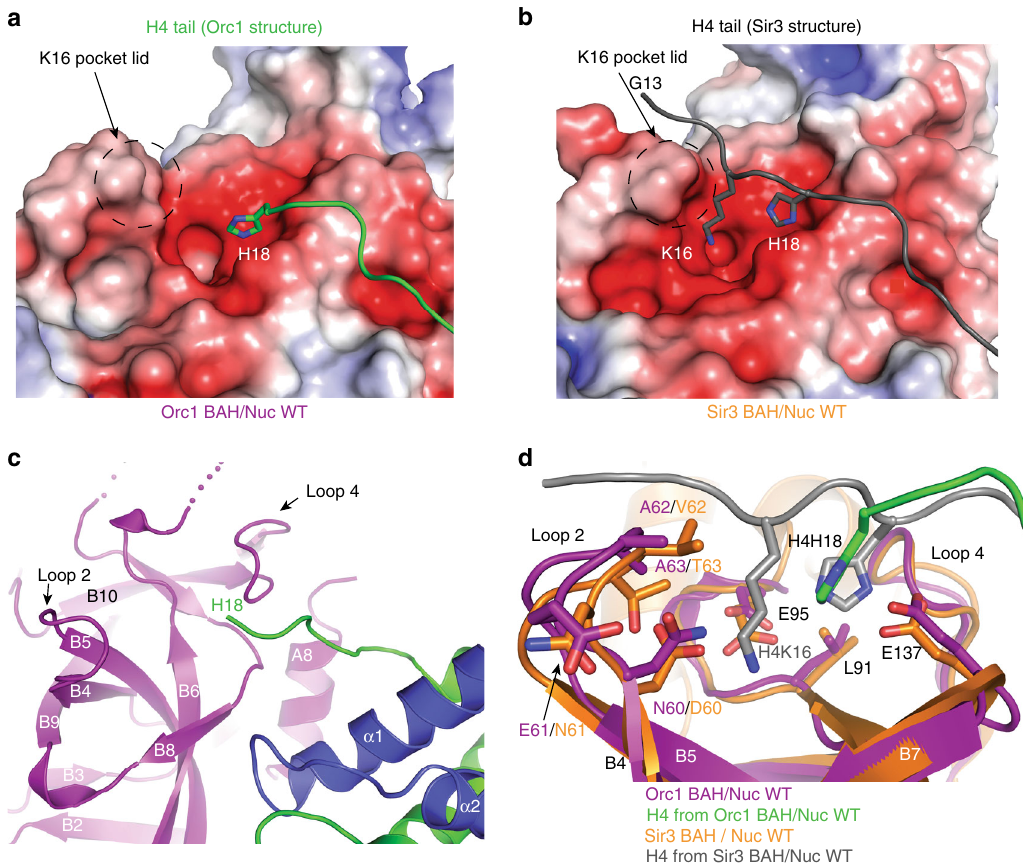
Fig. 2 H4 tail recognition by Orc1 and Sir3 BAH domains. a Electrostatic surface potential representation of Orc1 in complex with the nucleosome (positive, blue; negative, red). Histone H4 tail, green. b Electrostatic surface potential representation of Sir3 BAH in complex with the nucleosome (PDB ID: 4KUD). Histone H4 tail, gray. c Overview of H4 tail interface highlighting the secondary structure elements in histones and in Orc1. d Detailed view of superimposed pockets of Orc1 BAH domain (purple) and Sir3 BAH domain (orange) from the respective nucleosome complex structures. H4 tail in Orc1 structure (green) and in Sir3 structure (gray). Residues that make important contacts are depicted as